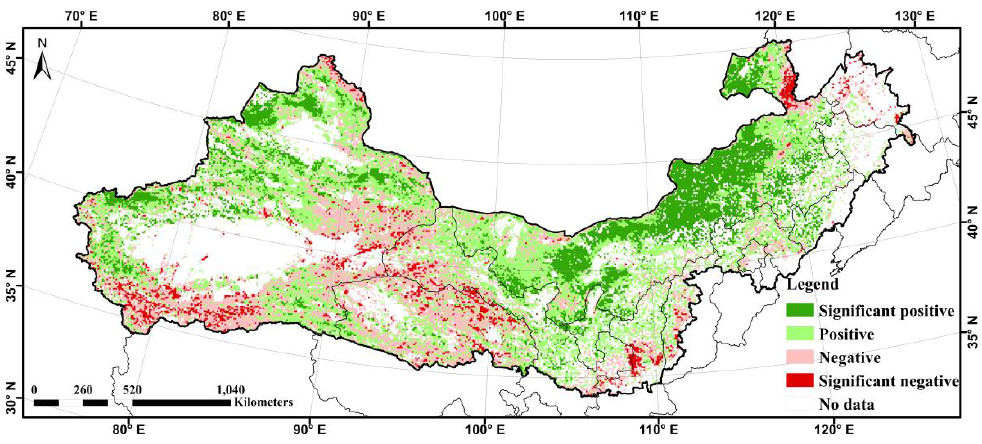
Figure 4. Spatial pattern of significant change for the accumulated NDVI in growth seasons from 1982–2006.